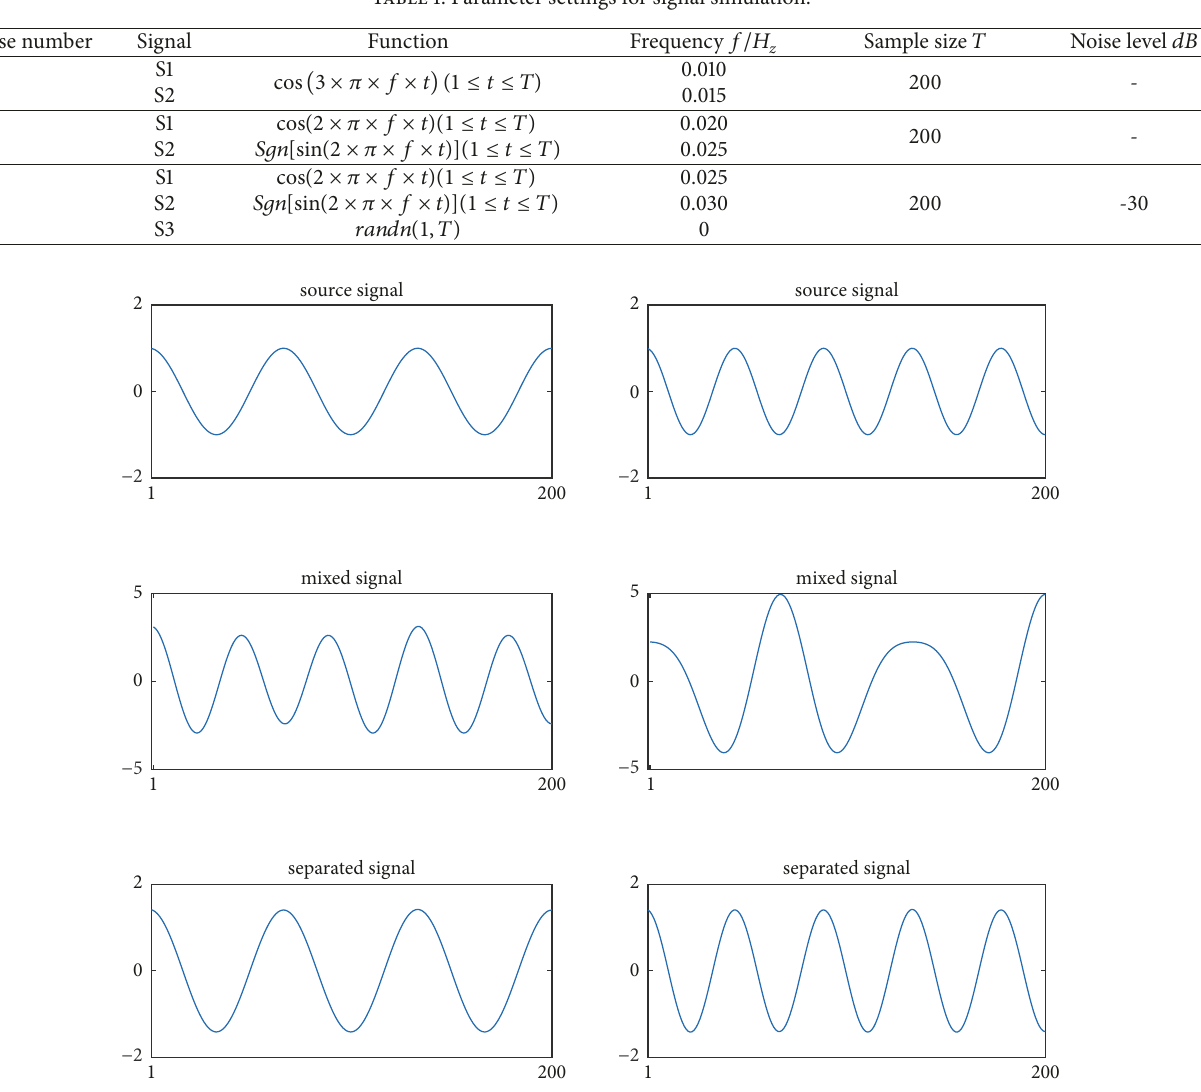
Figure 1: The decoupling of two cosine signals with similar frequency.